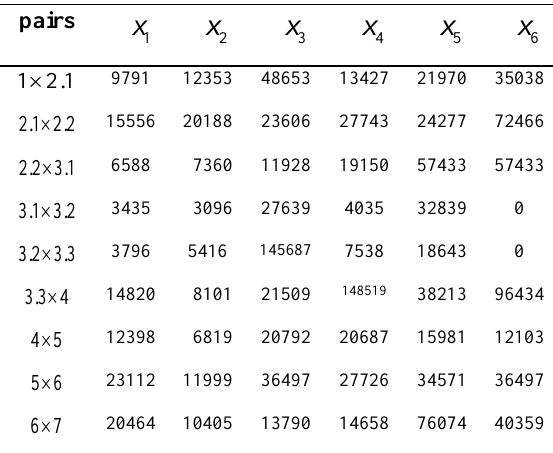
Table 6. Chi-square test results for pair wise comparison of clusters.